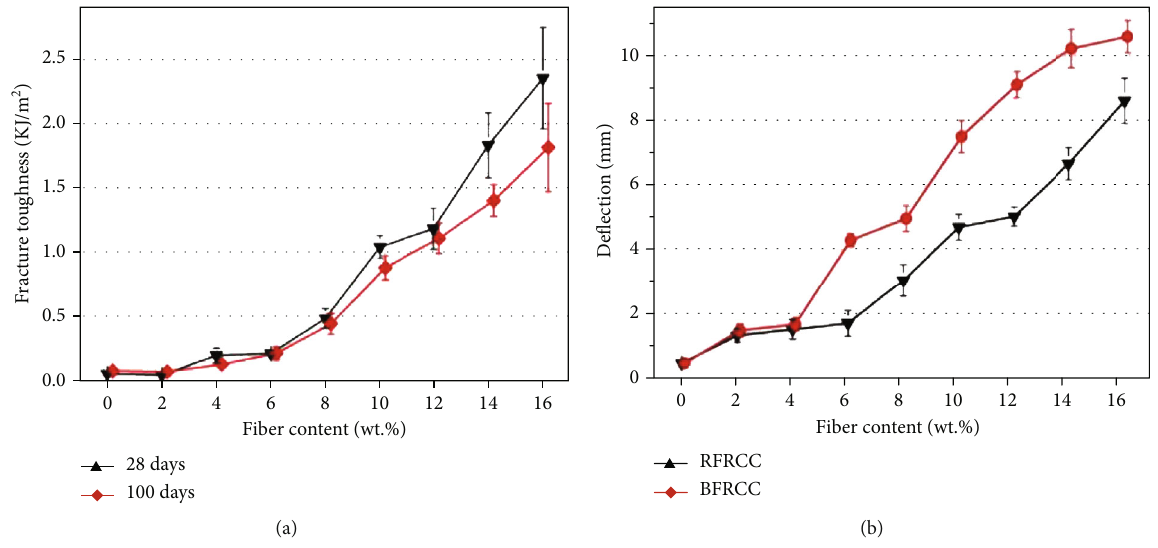
Figure 3: (a) In fl uence of fi ber content on fracture toughness and (b) in fl uence of fi ber content on composite deformation [78]. Table 4: Bulk density of CFCCs at 28 days (g/cm 3